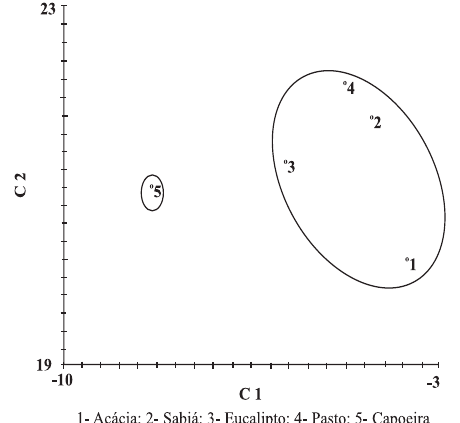
Figura1. Dispersão gráfica das coberturas vegetais em relação aos dois primeiros componentes principais, com base no pH, Al 3+ , P e SB do solo sob diferentes coberturas